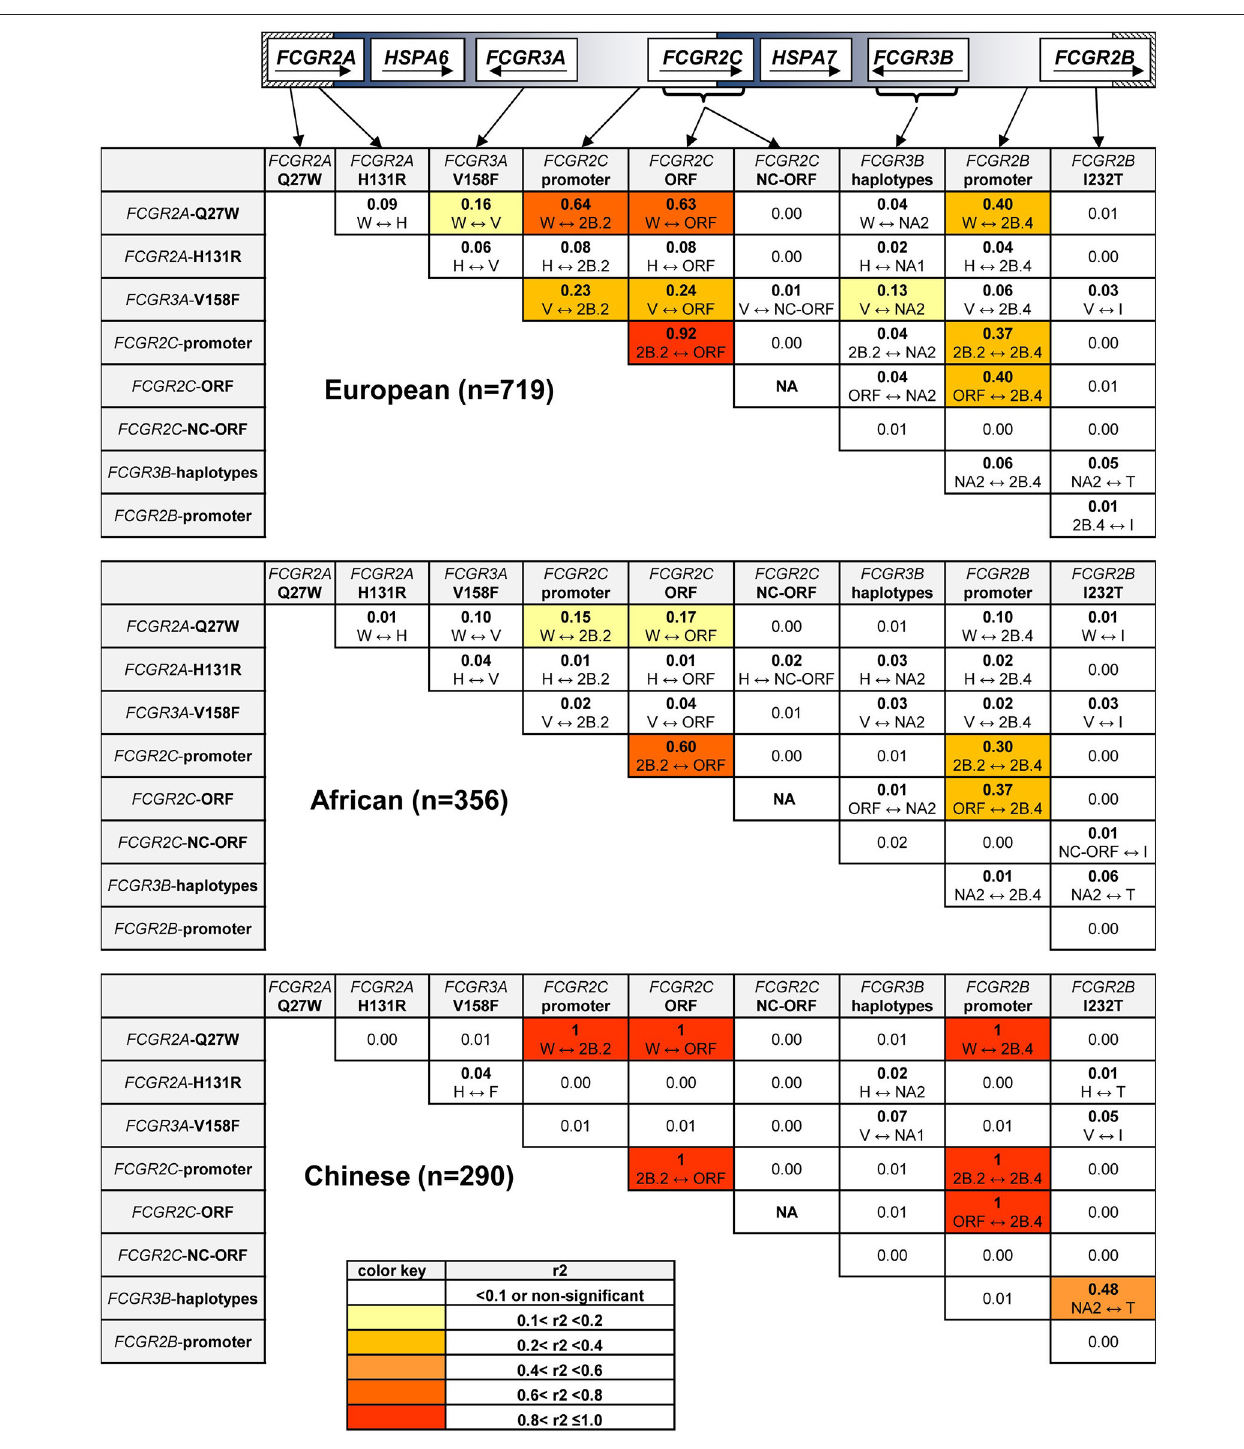
Frontiers in Immunology | www.frontiersin.org